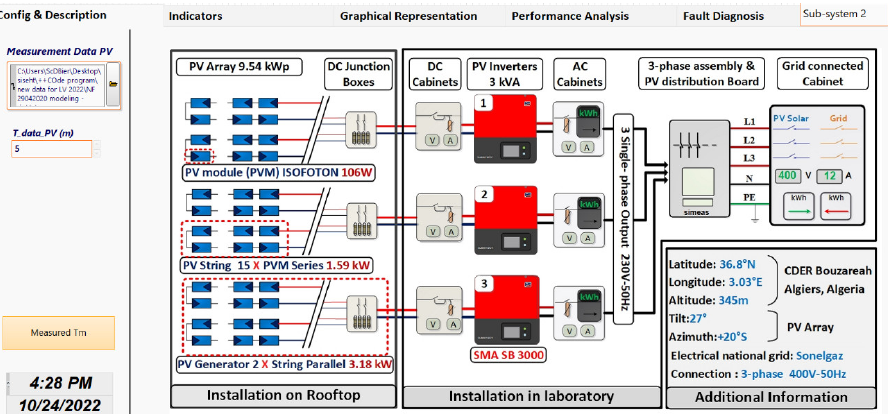
Figure 14. Designed interface for dynamic modeling and performance analysis.